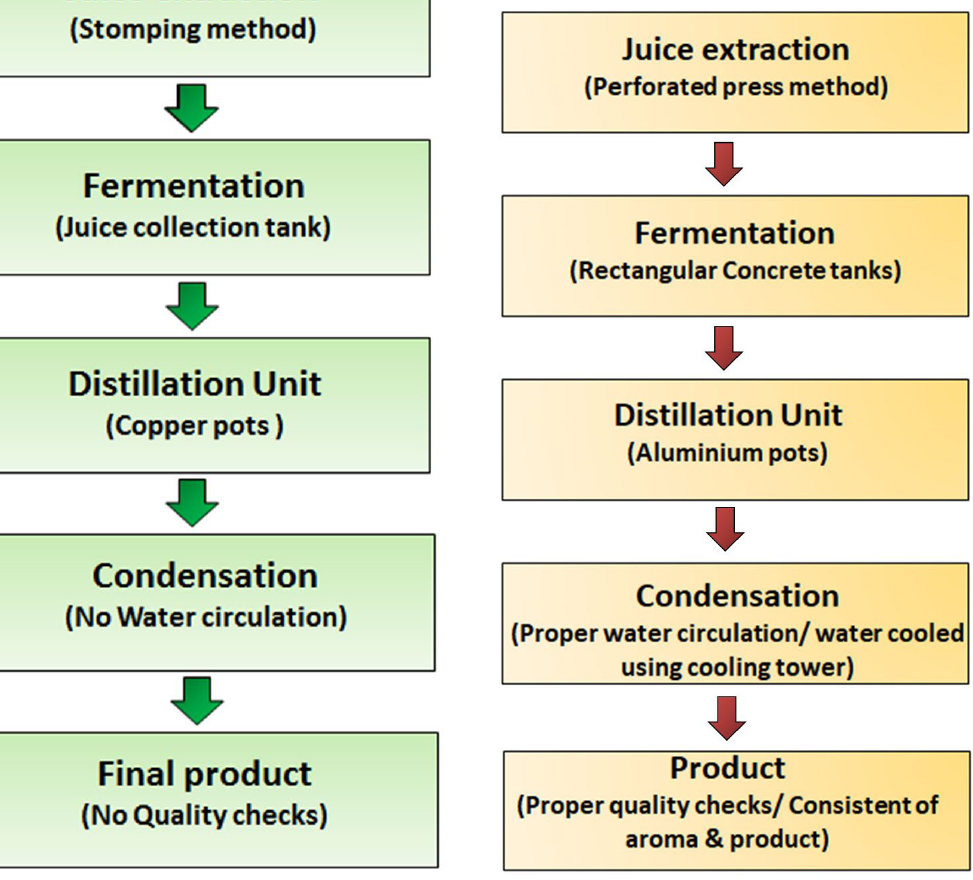
Fig. 3. Feni Production Process Involved in Production Unit-I.